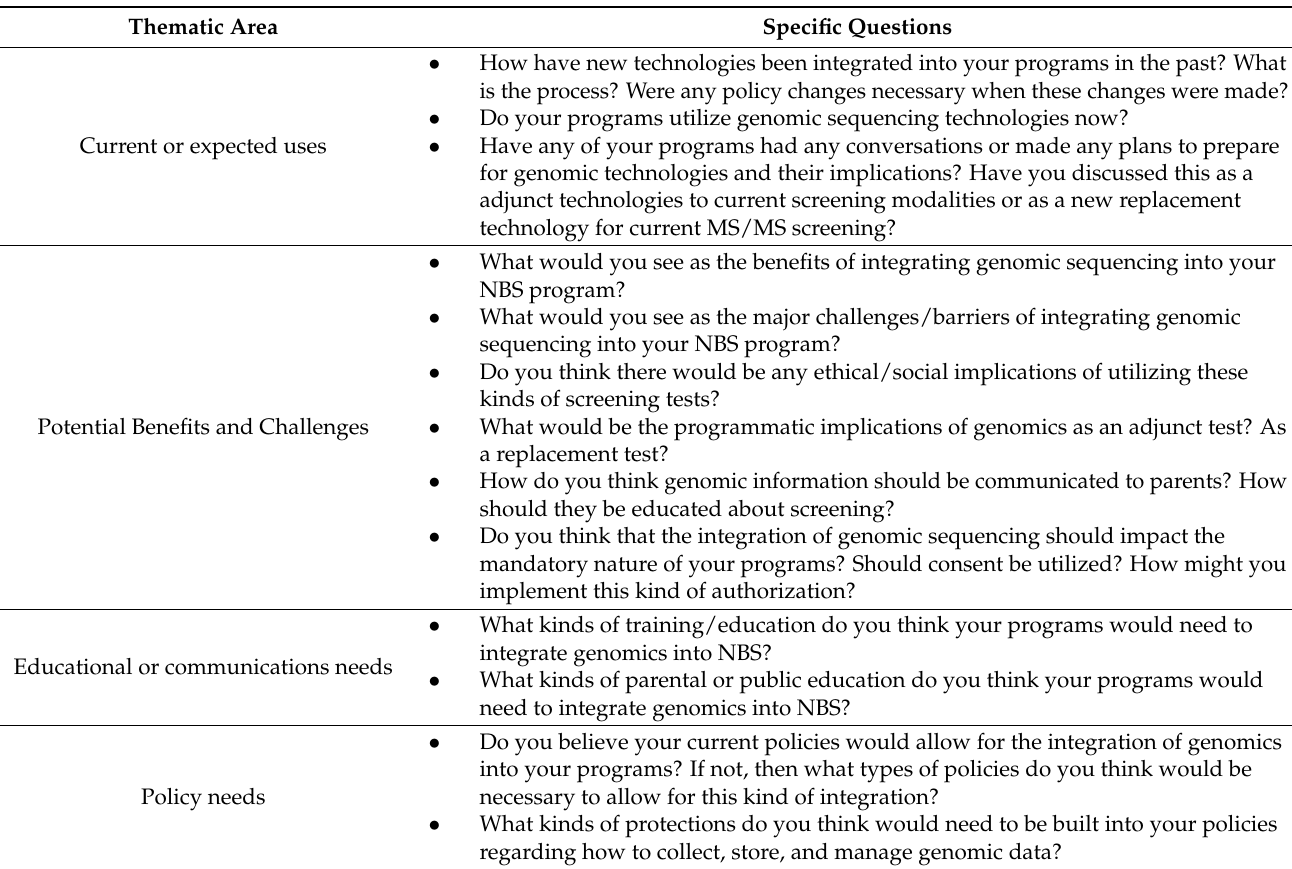
Table 1. List of primary focus group guide